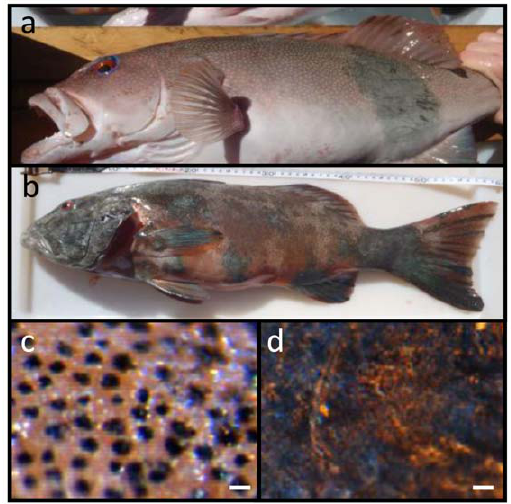
Figure 1. Lesions were present on approximately 15% of the sampled population of Plectropomus leopardus ; a) affected individual showing , 10% coverage of body surface; b) P. leopardus with almost complete coverage . 90%; c) healthy tissue under light microscope and d) the lesion. Scale bars=20 m